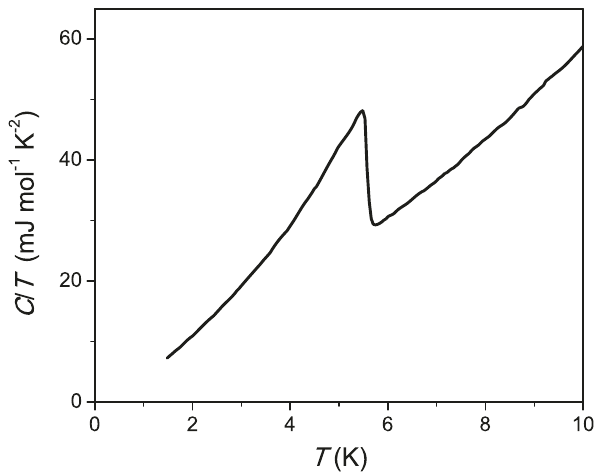
Fig. 6 Zero- fi eld speci fi c heat C / T of the NbS 2 single crystal used in this study. A sharp superconducting transition is centered at T c =